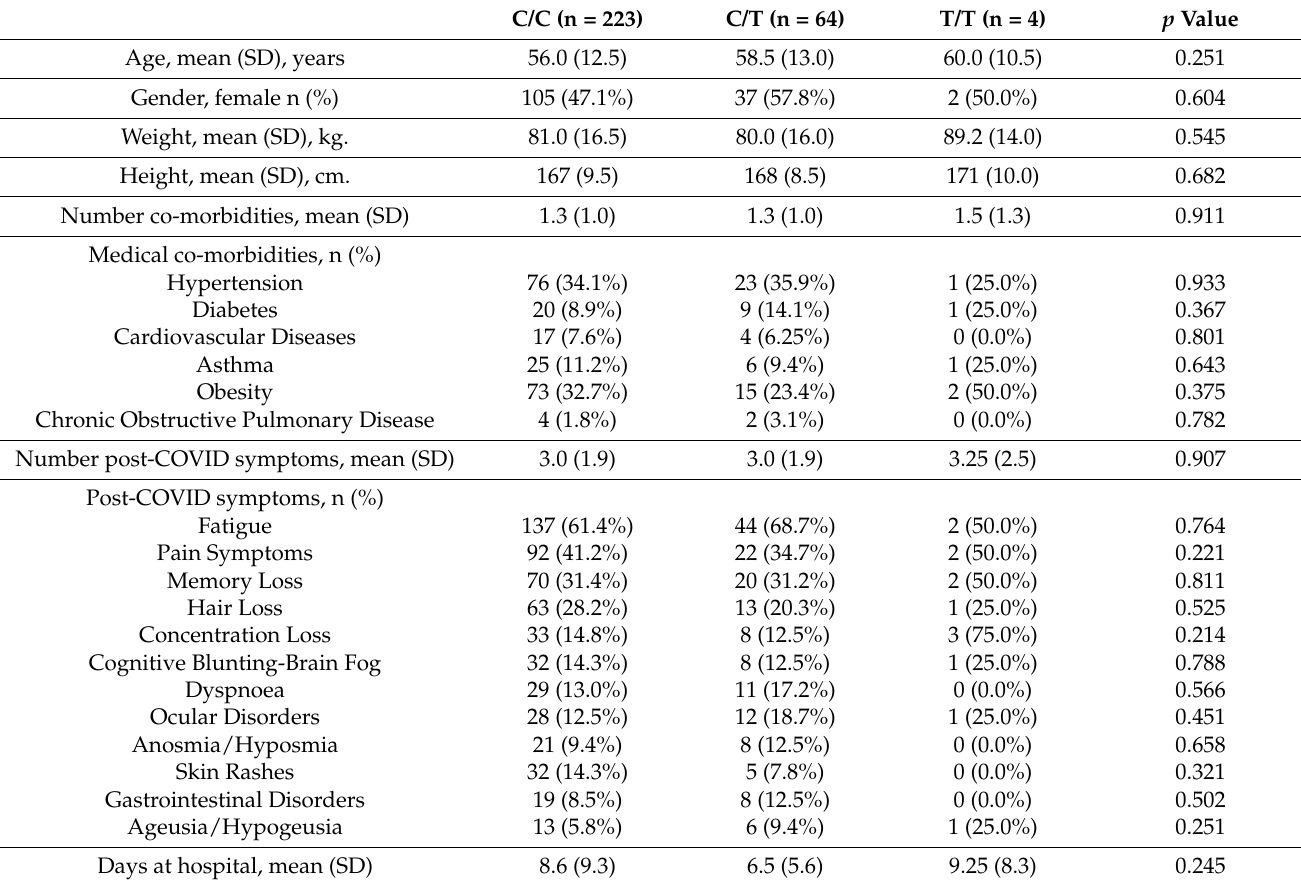
Table 4. Pre-Infection data and post-COVID symptoms according to the TMPRSS2 rs12329760 Polymorphism Genotype (n =